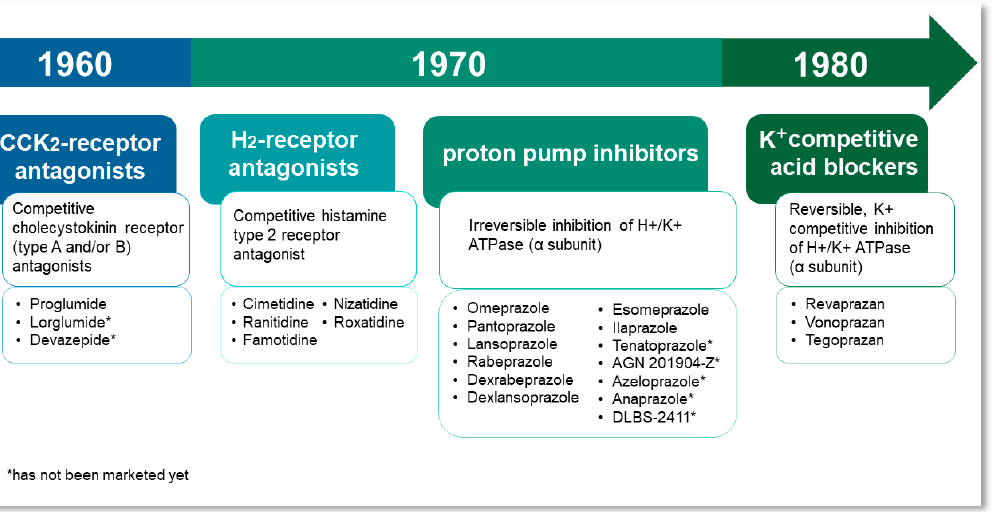
Figure 1. Antisecretory drugs